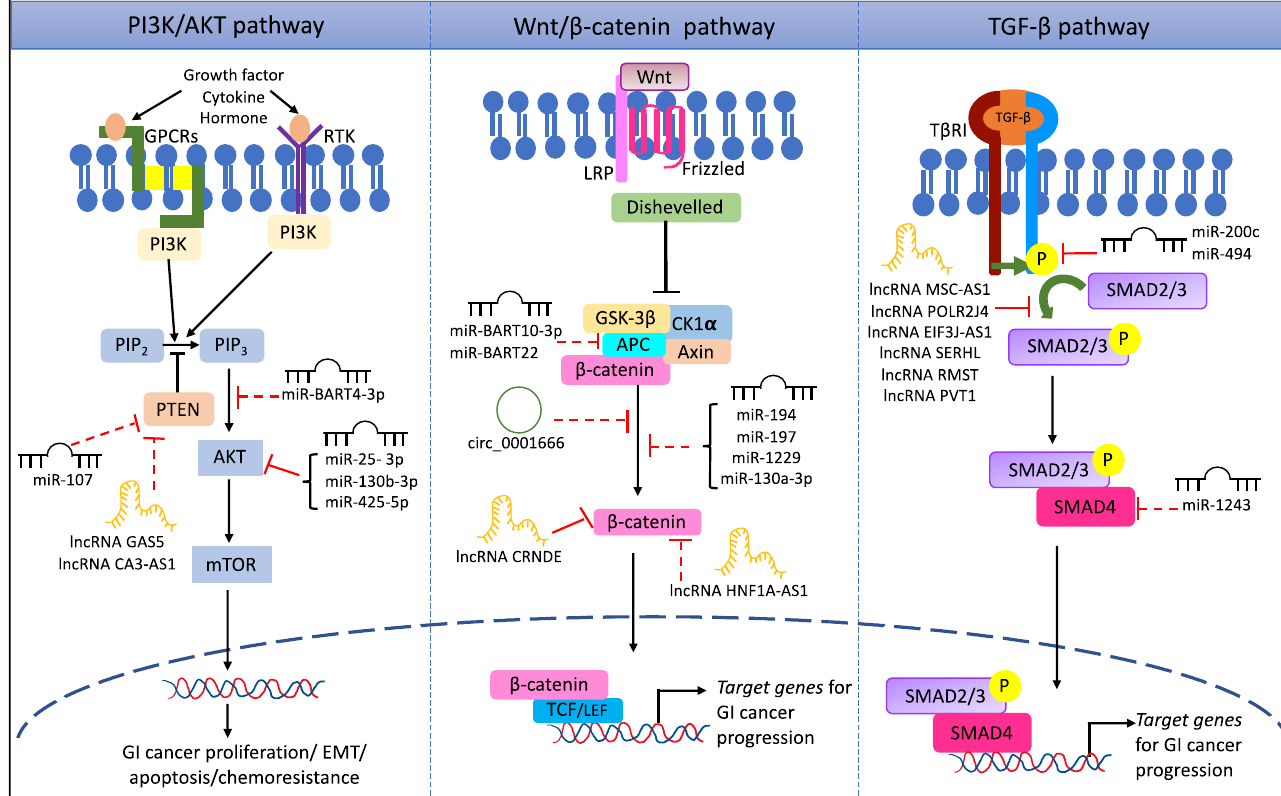
Figure 1. NcRNA-mediated regulation of signal transduction pathways in GI cancer progression. Representative illustration of different ncRNA-mediated dysregulation of A. PI3K/AKT, B. Wnt/ β - catenin, and C. TGF- β pathways. It should be noted that the ncRNA-mediated dysregulation of signal transduction pathways is not limited to the above pathways or ncRNAs; the red dotted line represents inhibition, and the red continuous frontal line represents activation by the respective